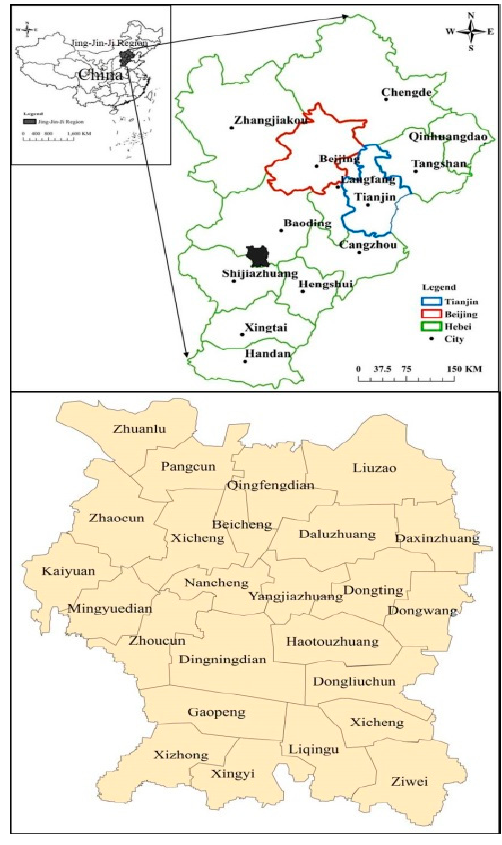
Figure 2. Location of Dingzhou City.